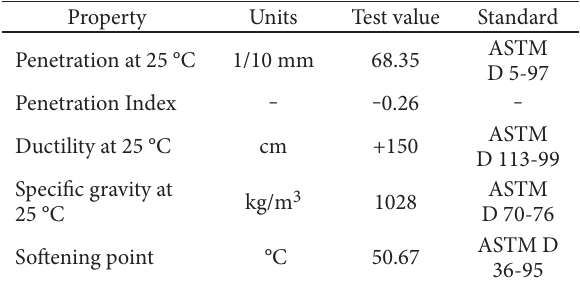
Table 1. Physical properties of the reference bitumen